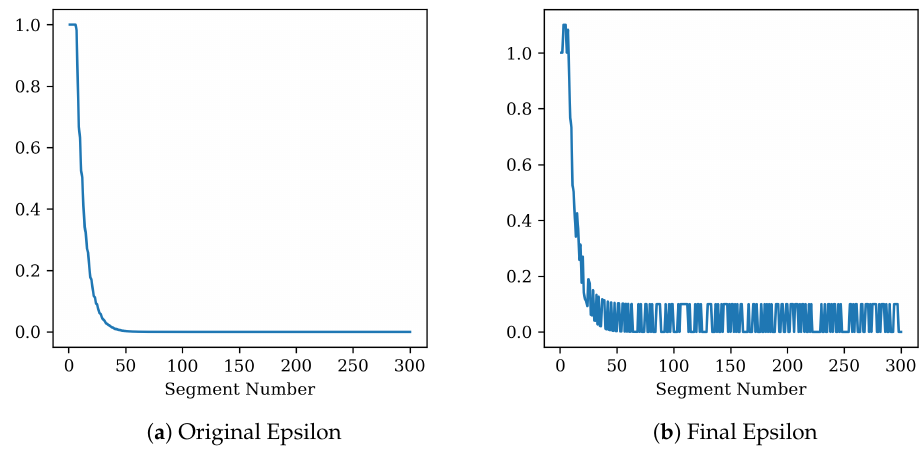
Figure 13. Epsilon. This means the probability that the agent performs a random action. ( a ) is the default epsilon, and ( b ) is the epsilon that responds according to the buffer status of the client.